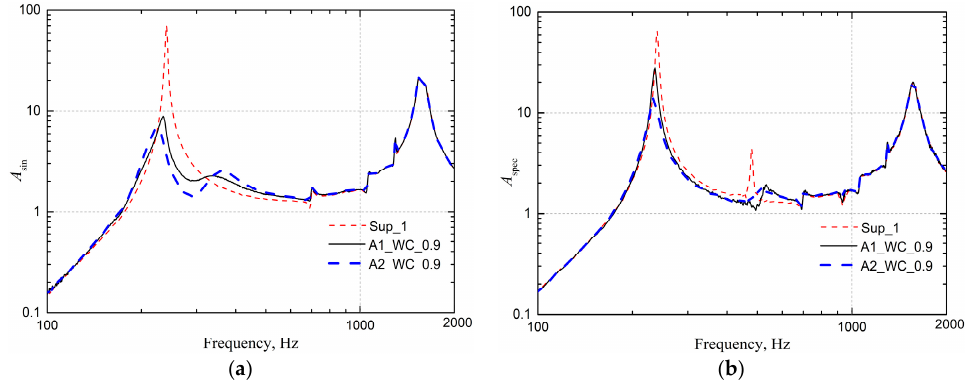
Figure 14. Experiment results of Tungsten carbide powder for A1 and A2 cavity (layering in Y-direction of the cavity): ( a ) Sinusoidal excitation; ( b ) Random excitation.